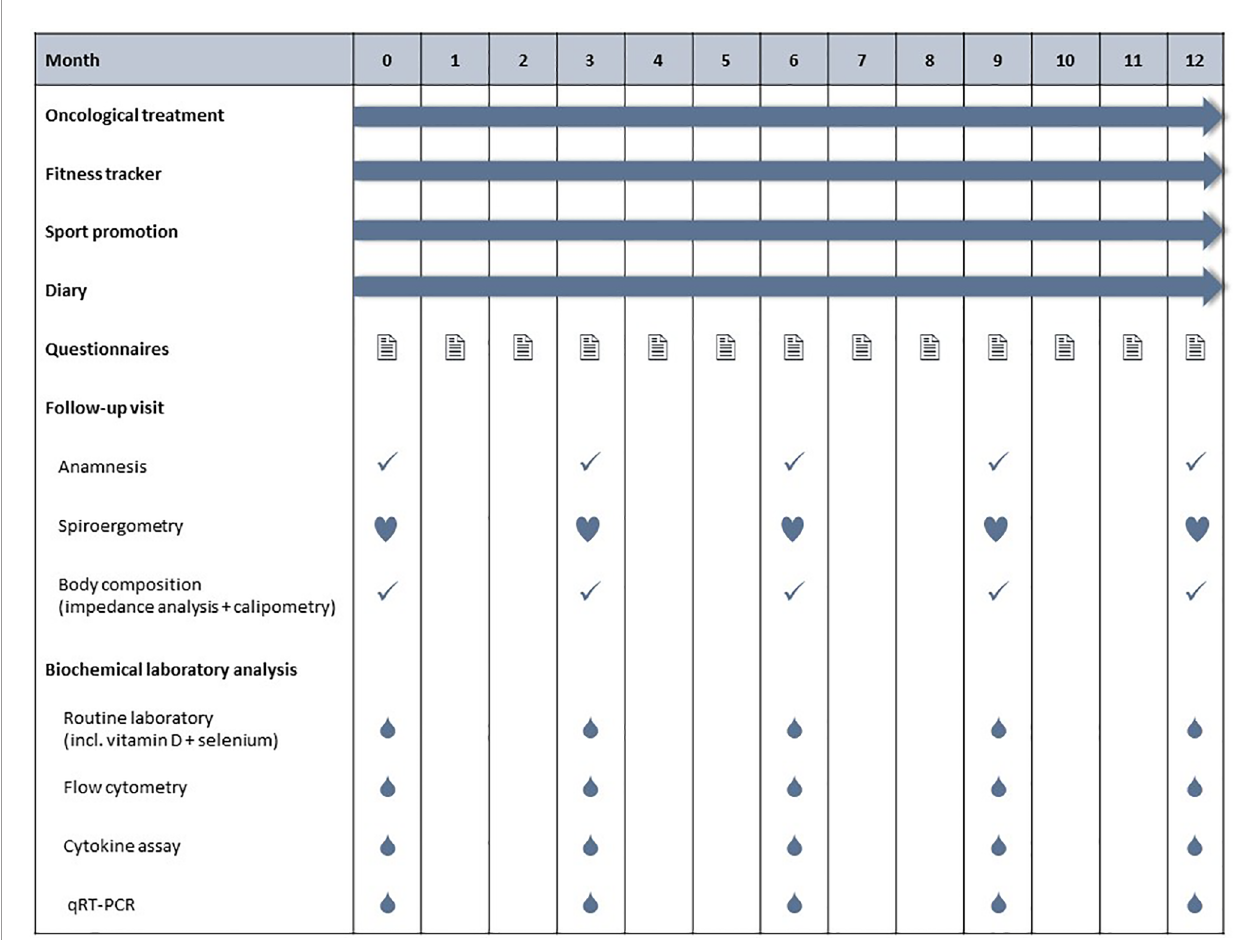
FIGURE 1 | Schedule for the BEGYN study. All patients are asked to write down their physical activities in a diary (type and duration of exercise) and to continuously wear a fi tness tracker. Study visits are scheduled quarterly, with the fi rst visit taking place before initiation of antineoplastic